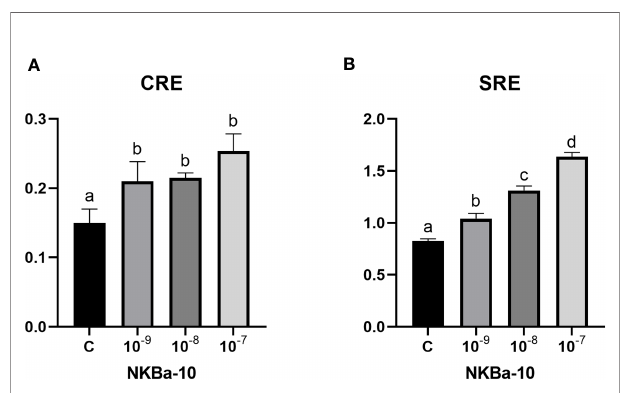
FIGURE 8 | (A) NKBa-10 peptides induced CRE driven promoter activities co-transfected with zebra fi sh tacr3a1 . (B) NKBa-10 peptides induced SRE driven promoter activities co-transfected with zebra fi sh tacr3a1 . The different lowercased letters indicated signi fi cant differences (P